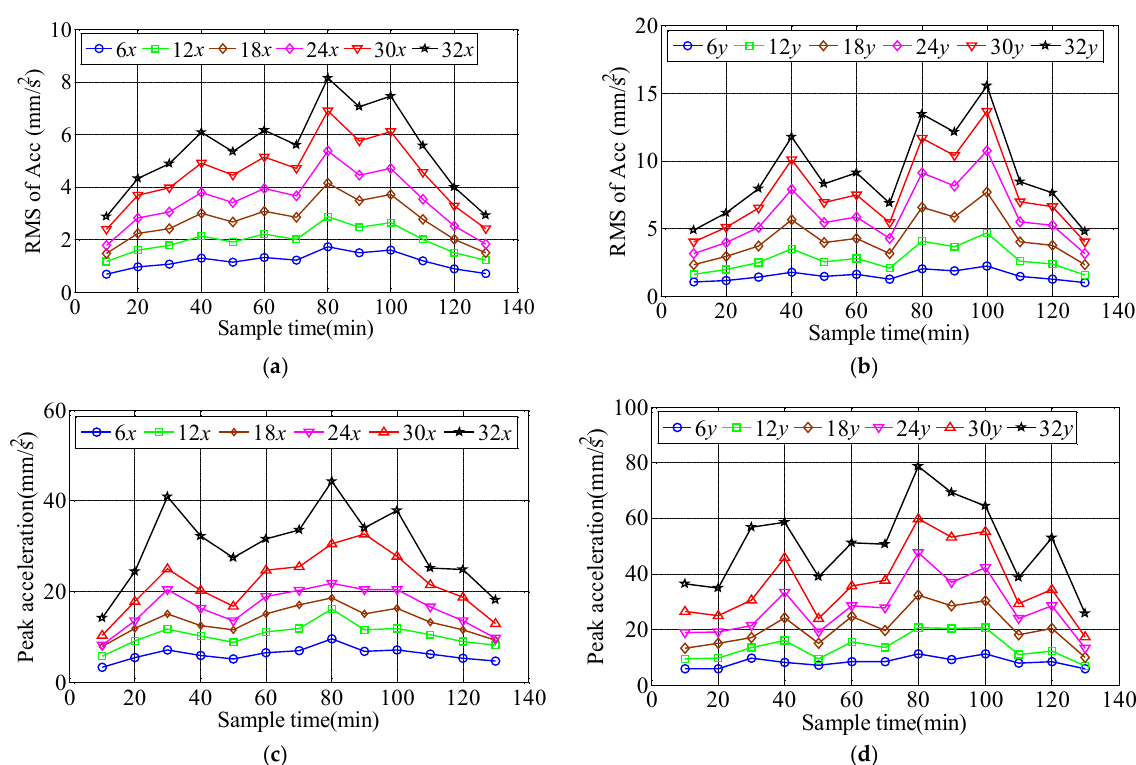
Figure 6. The 10-min variations of the RMS of Acc and peak accelerations along longitudinal and lateral direction during Typhoon Sarika. ( a ) RMS of Acc along x -axis; ( b ) RMS of Acc along y -axis; ( c ) Peak acceleration along x -axis; ( d ) Peak acceleration along y -axis.